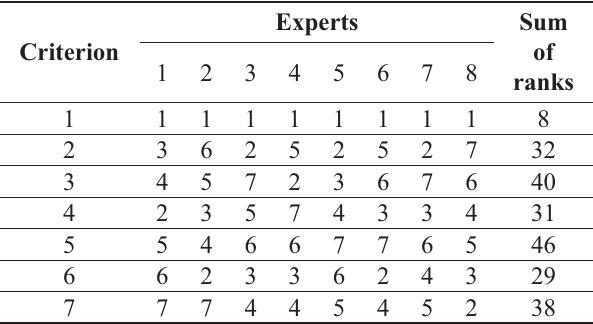
Table 4 . Ranking of Group 1